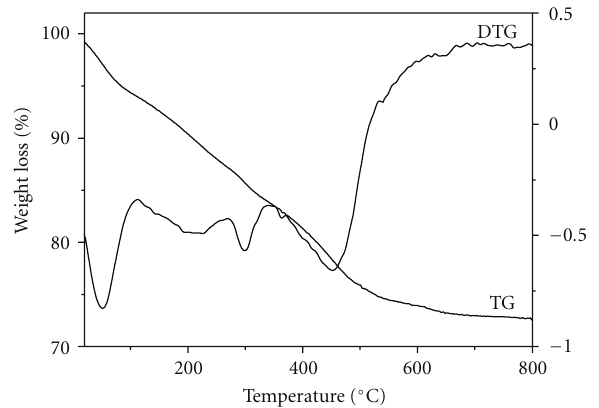
Figure 4: TG-DTG curve for APTMPP-MPS-TiO 2 .